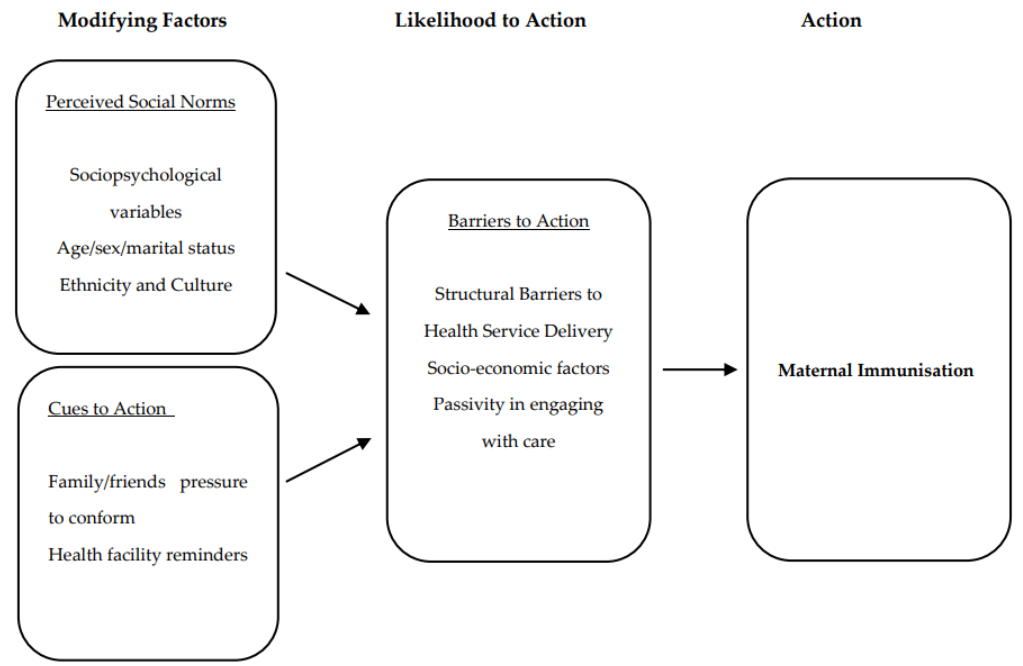
Figure 1. The Health Belief Model, adapted from Rosenstock et al.